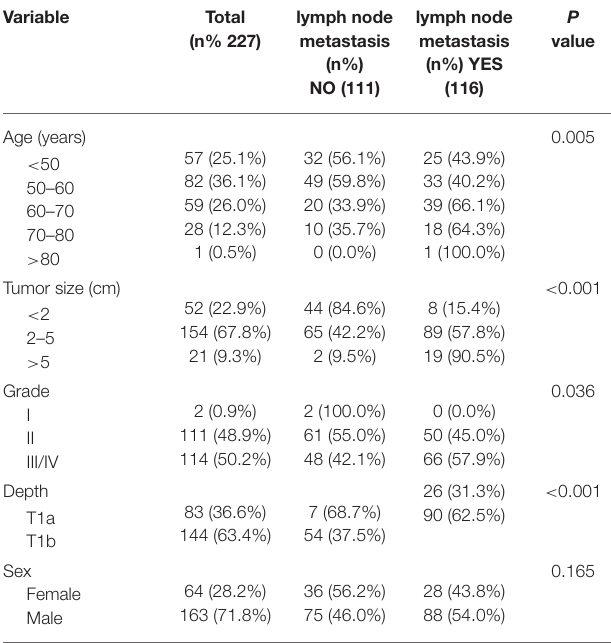
TABLE 4 | General characteristics and lymph node metastasis of the external verification group.